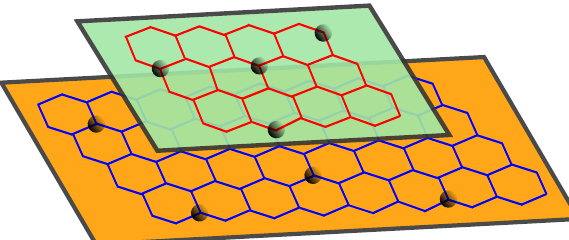
Figure 1: Schematic of the double monolayer graphene system with different areas. The number of electrons in the top (bottom) monolayer is N t a specific monolayer is attached with two fluxes from the same monolayer and one flux from the other